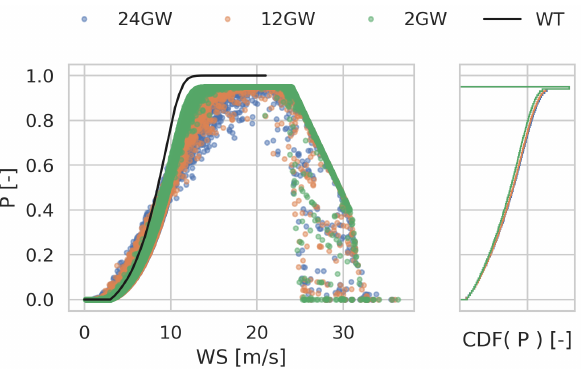
Figure 9. Example of resulting aggregated power curves for an example location on German waters. Power (P) versus wind speed (WS) (figure left ) and power versus cumulative density function of power (CDF(P)) ( right figure). WT stands for wind